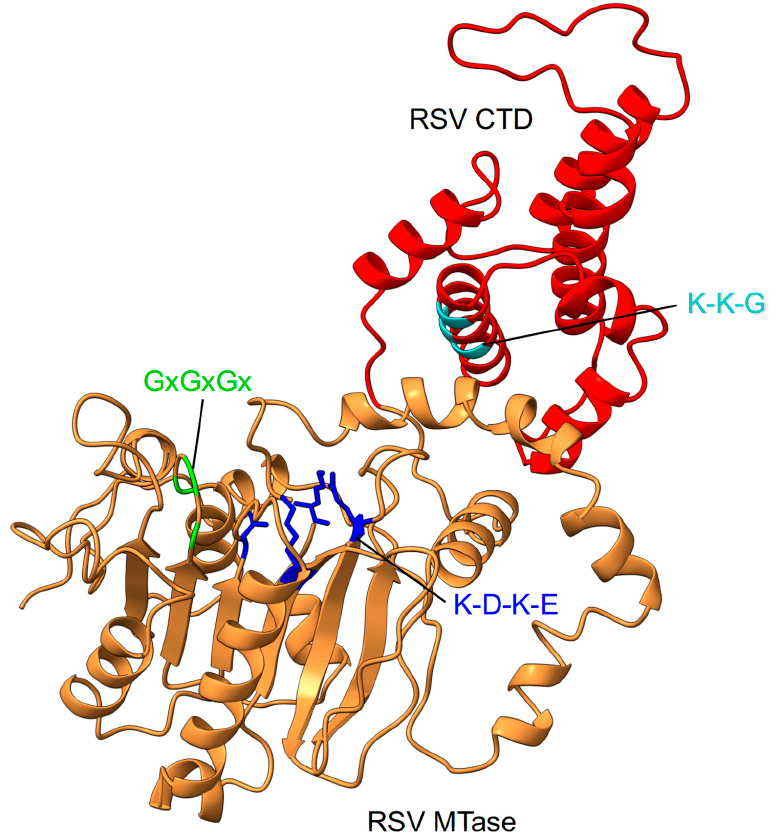
Figure 7. RSV MTase–CTD features. The RSV MTase is shown in orange ribbons and the CTD domain in red. Conserved sequence motifs on both domains are highlighted. The MTase catalytic tetrad is shown as